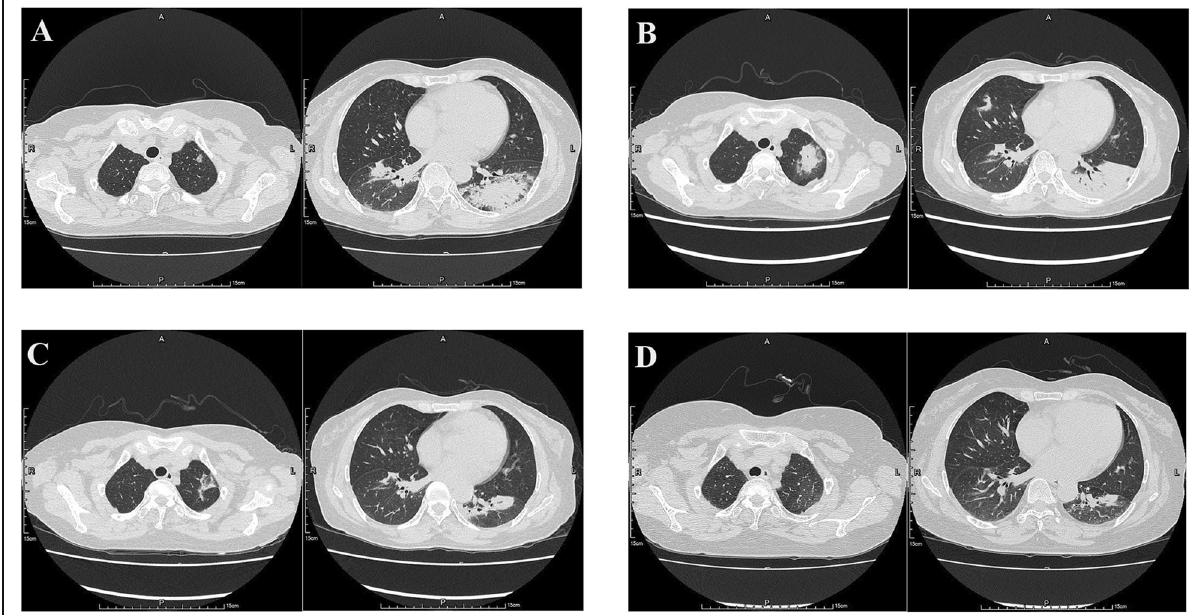
Fig. 1 The initial and follow-up CT images of case 1. A CT of one day before admission showed bilateral consolidations, predominantly in both lower lobes, with basal and subpleural distribution, and patchy-like ground-glass opacity in the left upper lobe. B CT images on day 18th of admission showed lesions progression. C CT images of follow-up at the 12th day of the steroid treatment and D CT of follow-up at 3rd